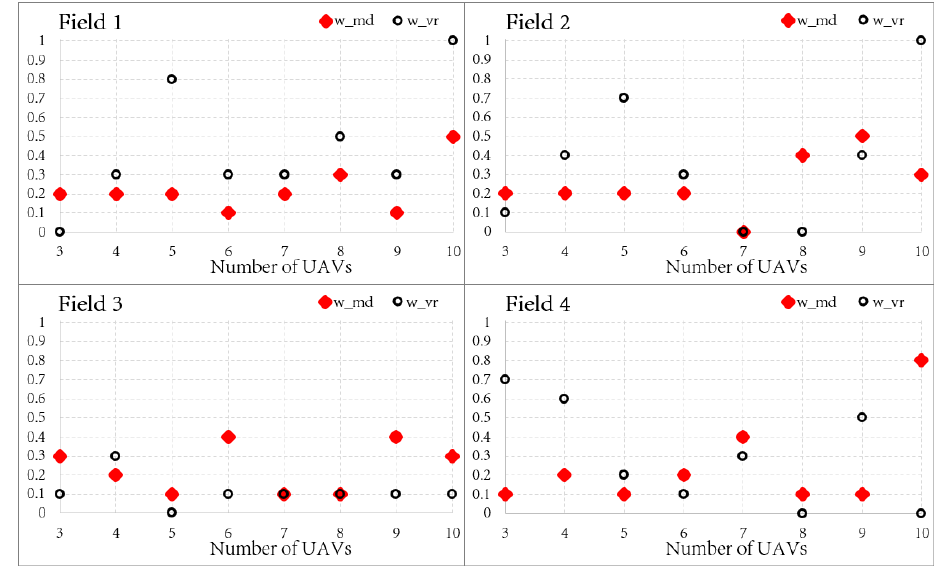
Figure 10. Weight parameters ( w md and w vr ) tuning to optimize the uniform distribution of the UAVs in the map (with CS = 30 m). The tuning is performed for all of the four maps shown in Figure 6.